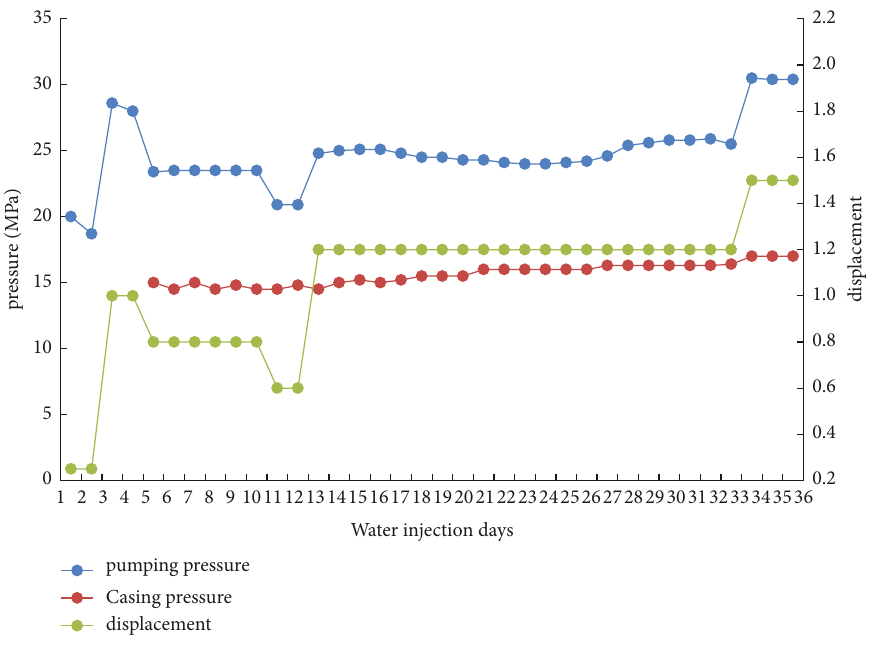
Figure 6: Pumping curve of pressure drive